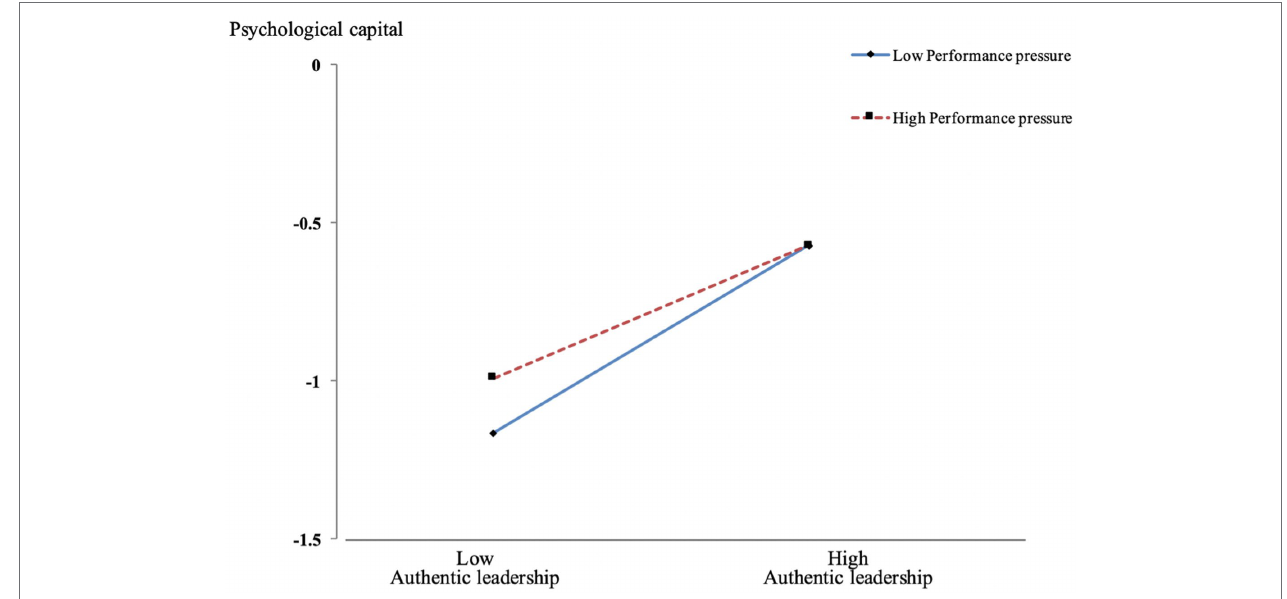
FIGURE 2 | Moderating effect of performance pressure of authentic leadership on the relationship between psychological